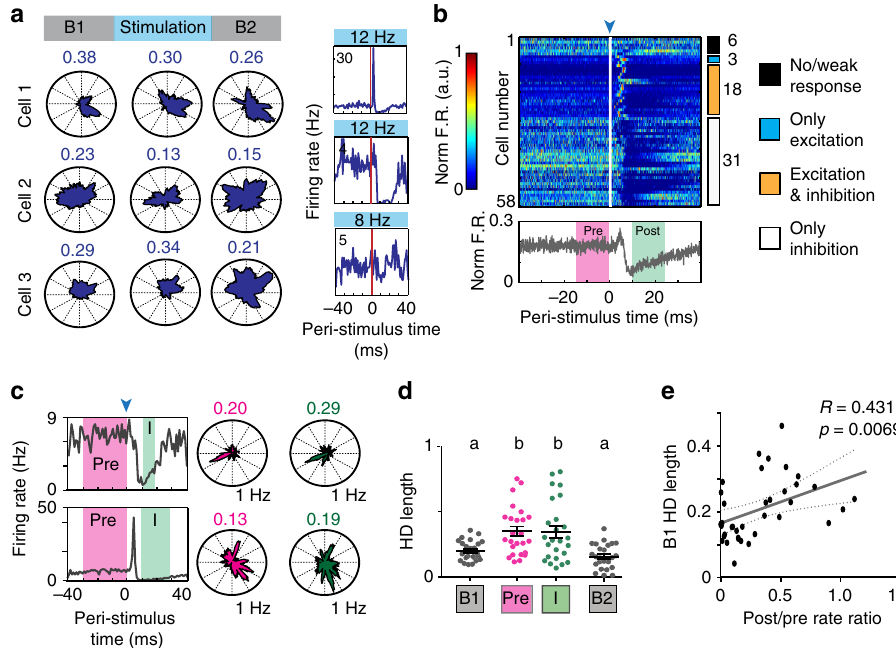
Fig. 6 Inhibition of broad HD cells did not reduce HD tuning. a Example broad HD cells retained their directional tuning regardless of their response to optical LIIP activation (shown in the rightmost plot). The HD score is indicated above each polar plot. b Peri-stimulus time plot for all broad HD cells. Cells are ordered by optogenetic response category with the number of cells in each category indicated to the right. Broadly tuned HD cells displayed heterogeneous responses to stimulation, but a large fraction was inhibited, as also seen in the mean normalized fi ring rate over all broad HD cells. c Examples of broad HD cells that were inhibited by LIIP activation. HD scores were calculated only for spikes during the inhibition period (I, green) and for an equal number of spikes from the period before light onset (Pre, magenta). d Quanti fi cation of HD tuning of all inhibited broad HD cells revealed no differences between Pre and I periods, but both windows had signi fi cantly greater HD tuning than baseline [one-way repeated-measures ANOVA, n = 25 cells from 7 mice, F (1.8,43.21) = 15.46, p < 0.0001], indicating that HD scores moderately increase when using fewer spikes in the analysis. Signi fi cantly different groups (Tukey ’ s multiple comparisons test, p < 0.05) are assigned different letters (a, b). The mean ± sem are shown. e The baseline HD score of inhibited broad HD cells was correlated with the reduction in fi ring rate by optical LIIP cell stimulation, measured as the ratio between fi ring rate after light onset [10 to 25 ms, Post, green in b ] and before light onset [ − 15 to 0 ms Pre, magenta in b ]. The results imply that increased baseline HD tuning was related to lower feedback inhibition [Pearson ’ s correlation, n = 38 cells from 7 mice, R = 0.431, p =